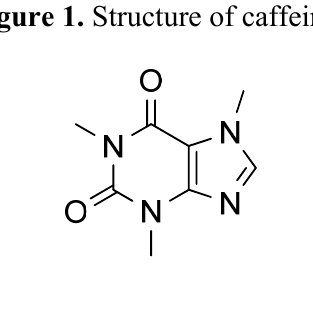
Figure 1. Structure of